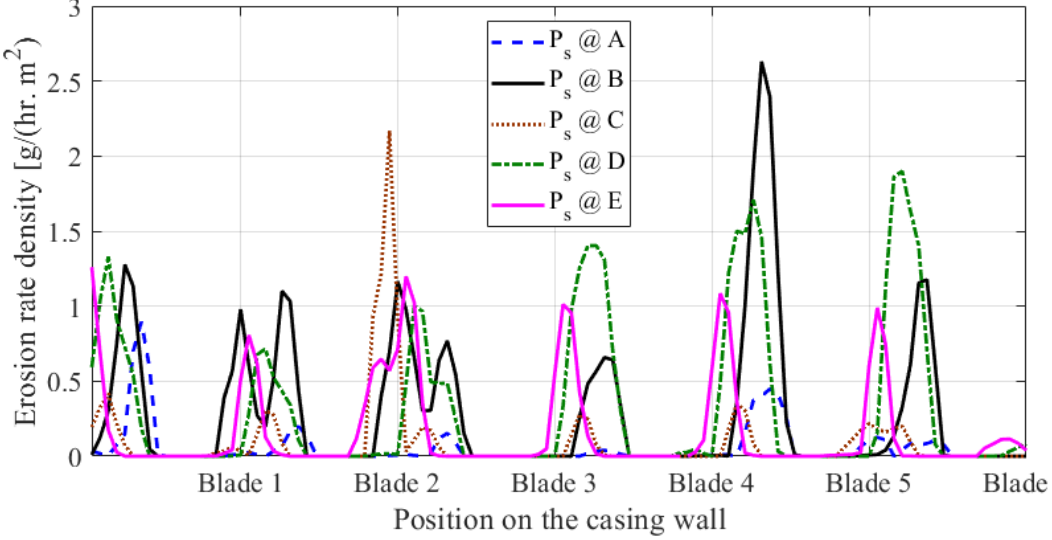
Figure 16. Variation of erosion density rate on the blade walls with different solid particles size and distribution values.